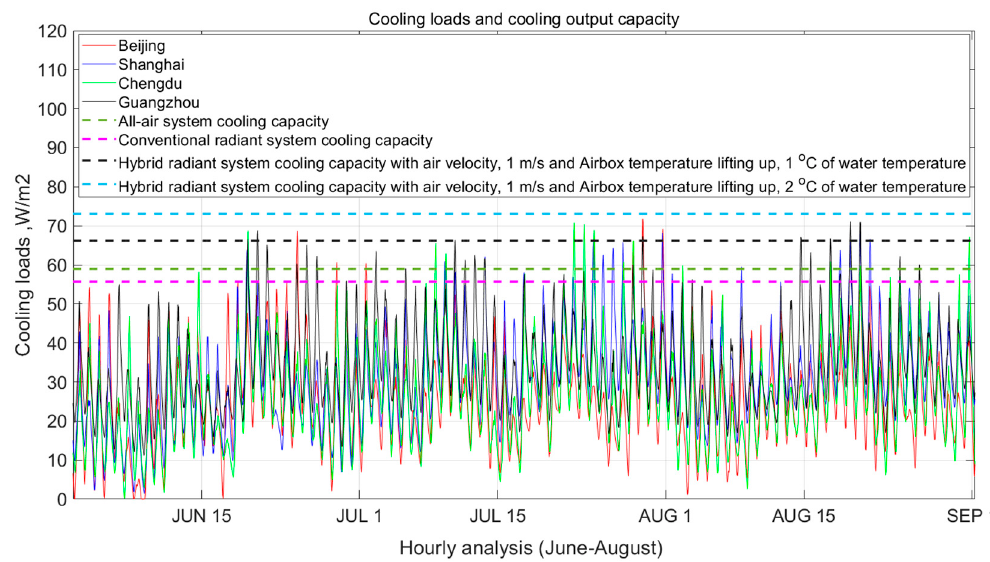
Figure 7. Cooling loads of the designed office room and the cooling capacities of the AAS, CRCS, and HRCS.